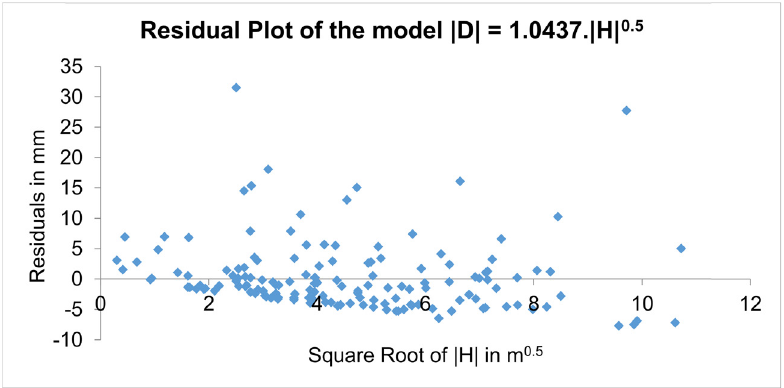
Figure 3: Pattern of the residuals of the regression model | D | = 1.0437 · H | | , where | D | denotes the absolute di ff erence between both measurements of the absolute value of the height | H | between the terminals of a line. The regression model is based on 146 lines given by Kääriäinen ( 1966, Table IX )